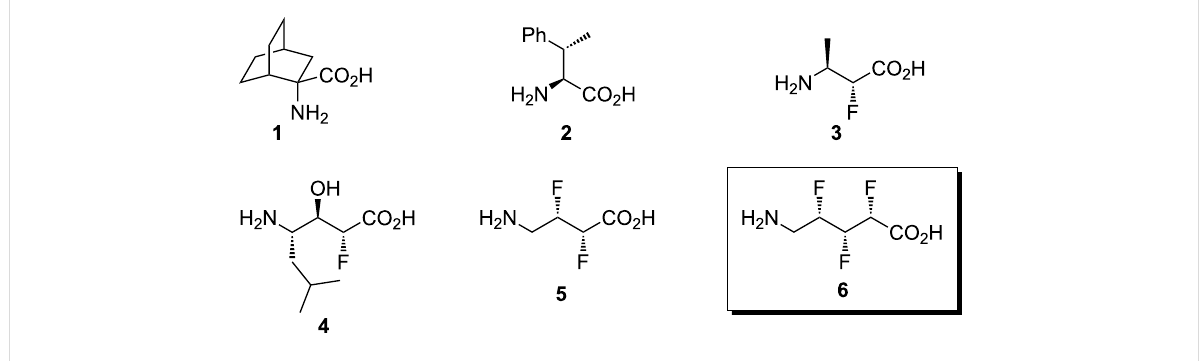
Figure 1: Examples of conformationally biased amino acids [1-10]. Compound 6 is a target of this work.